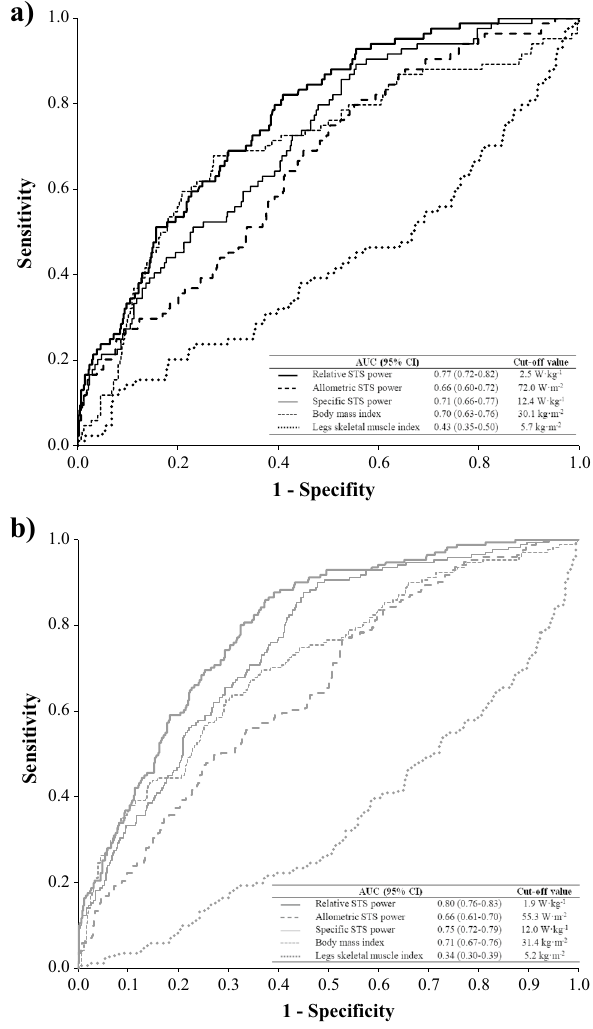
Figure 2. Receiver operator characteristic curves showing the ability of STS power and body composition measurements to discriminate between frailty status in men ( a ) and women ( b ) with their specific cut-off